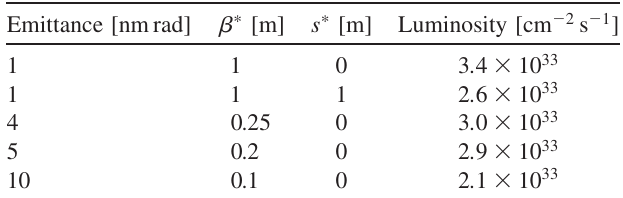
TABLE II. Luminosity at different sets of initial electron beam parameters. Emittance [nm